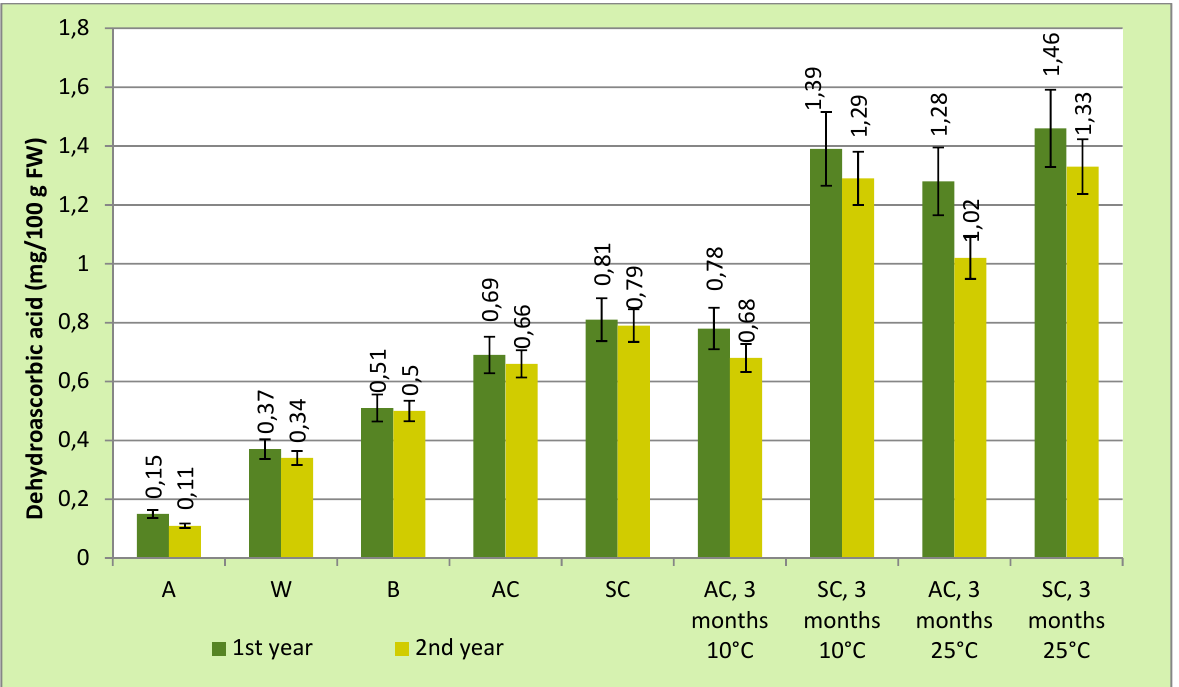
Figure 4. HPLC content of ascorbic acid during the technological flow of apricot compote fabrication and the 3 months preservation at 10 °C and 25 °C: apricot raw material (A), washed fruits (W), after blanching (B), apricots from compote (AC), and syrup from compote (SC), during two different years. Results are means of 3 determinations±standard deviation.